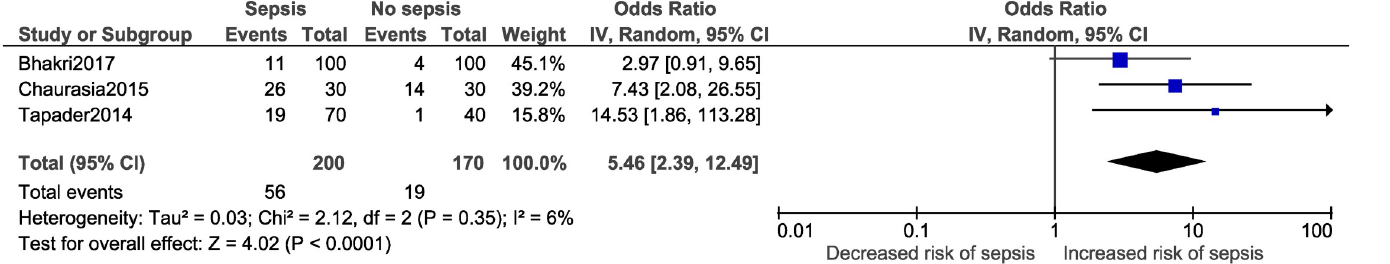
Fig 3. Forest plot showing a random-effects meta-analysis of outborn neonates with and without sepsis.